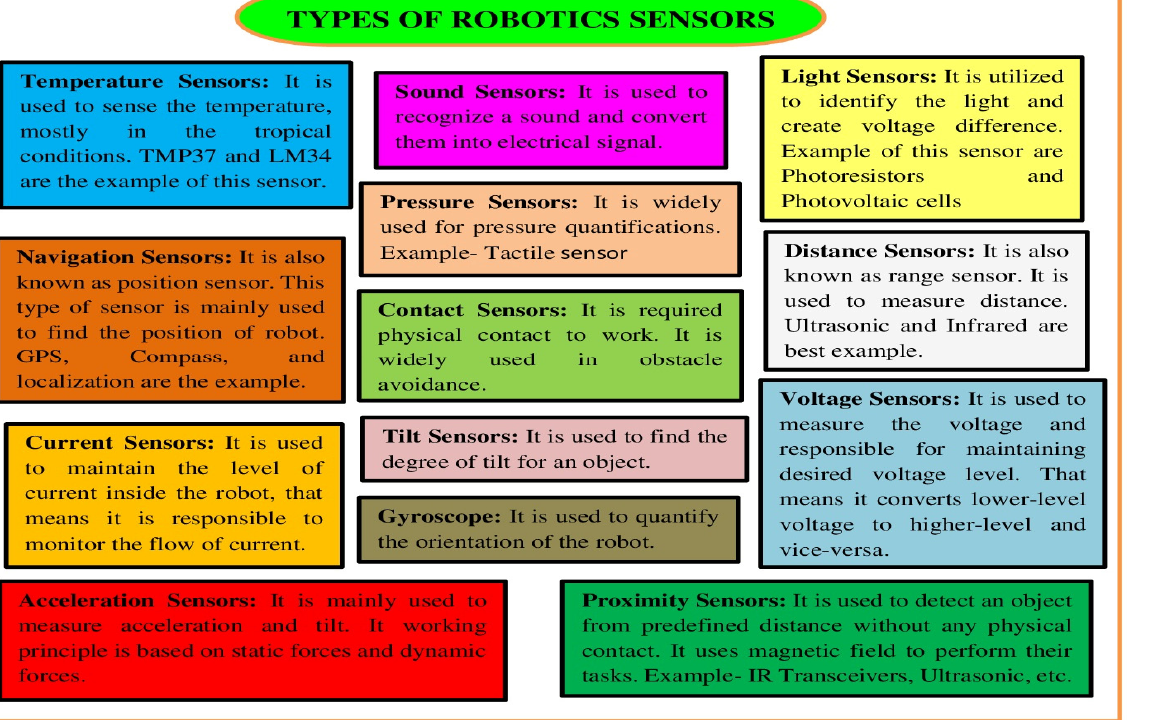
Figure 10. List of sensors utilized by the robots.